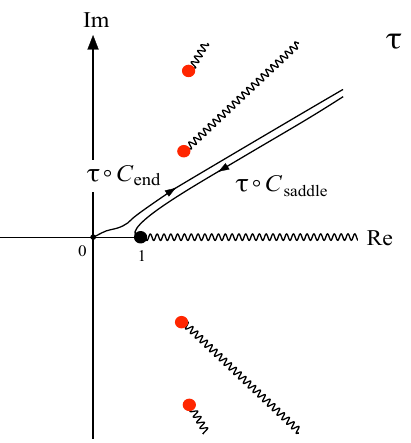
Figure 9 . Image of the steepest descent contours C end and C saddle in the Borel plane as (cid:18) approaches (cid:25) from below, for large (but not in(cid:12)nite) (cid:11) . In the limit (cid:11) ! 1 , the image of C end becomes a straight line connecting the origin to in(cid:12)nity at an angle of (cid:25) (cid:0) (cid:18)